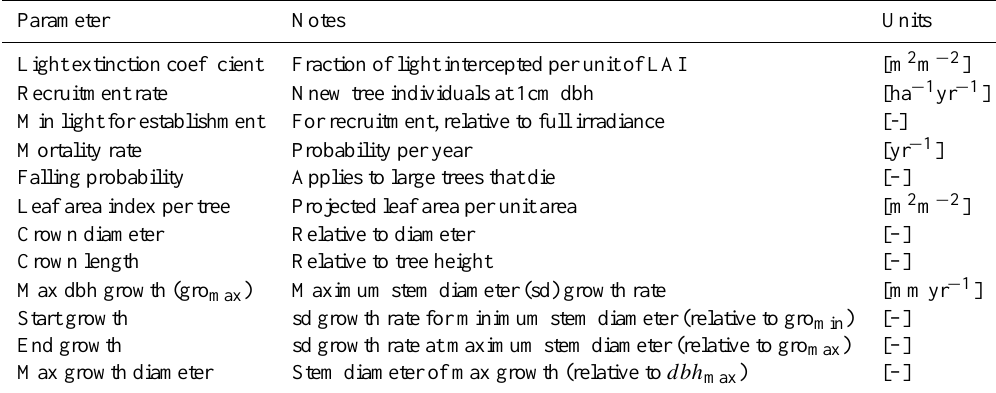
Table 1. Important model parameters and their interpretation. The parameter dbh max in the last line refers to the maximum diameter of a tree, which is a species or PFT-specific parameter of the model (see Dislich et al.,